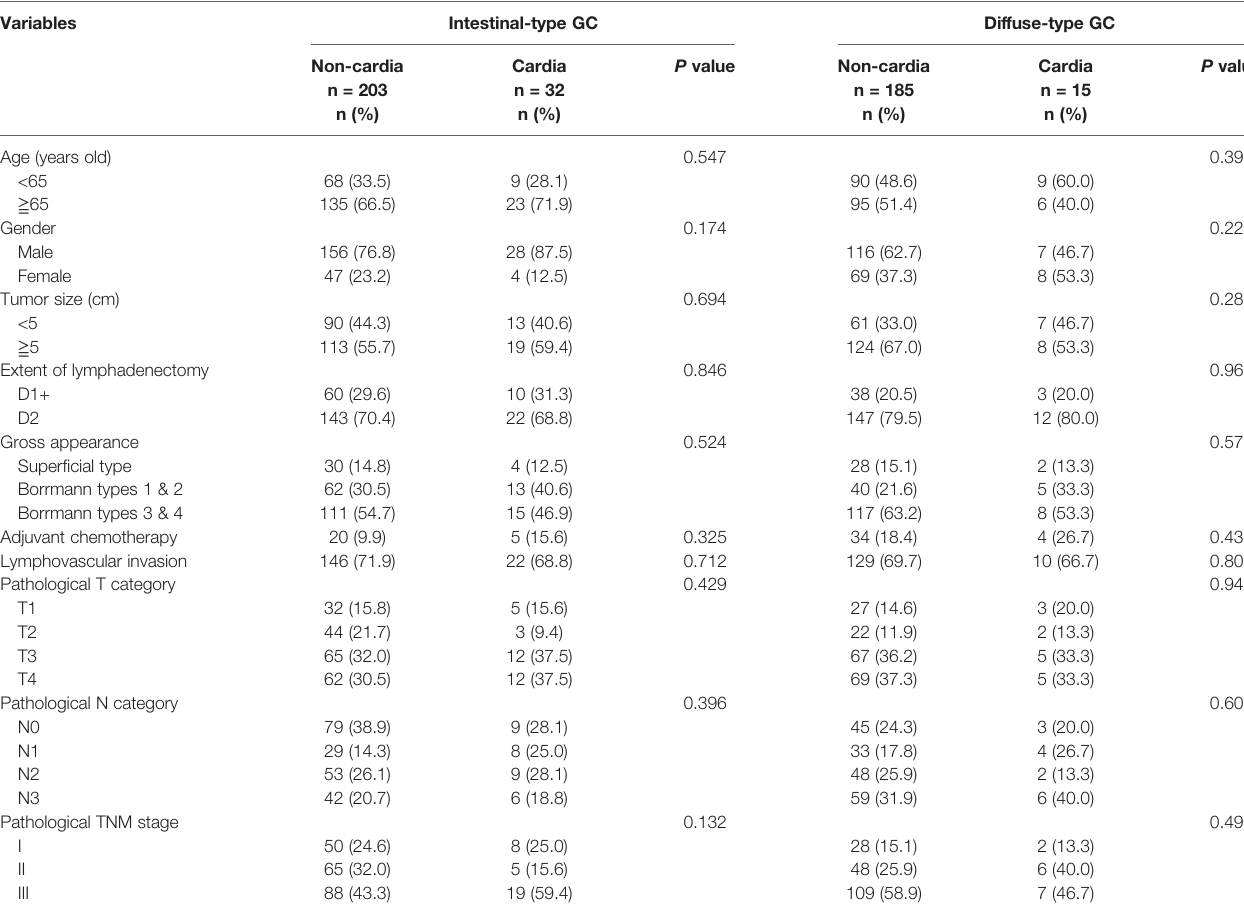
TABLE 2 | Clinical pro fi le between cardia and non-cardia GC patients in intestinal-type and diffuse-type GC.